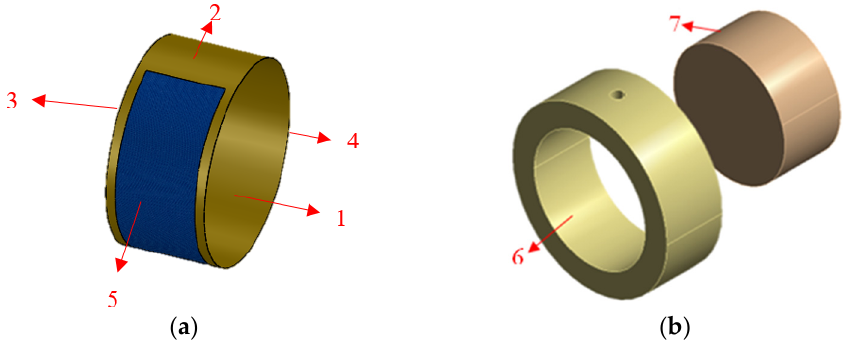
Figure 4. Boundary condition of computational ( a ) fluid domain; ( b ) solid domain; 1—moving wall; 2—stationary wall; 3—inlet; 4—outlet; 5—slip area; 6—contact with stationary wall; 7—contact with moving wall. Table 3. Boundary